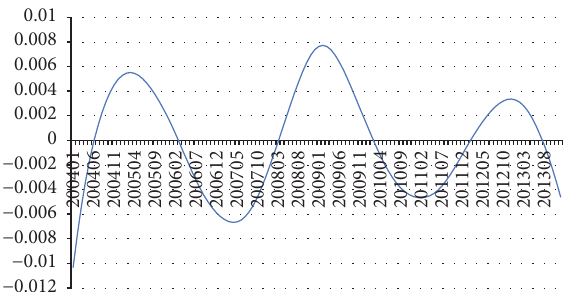
Figure 6: Relative error of the curve fitting about sequence {𝐺} in